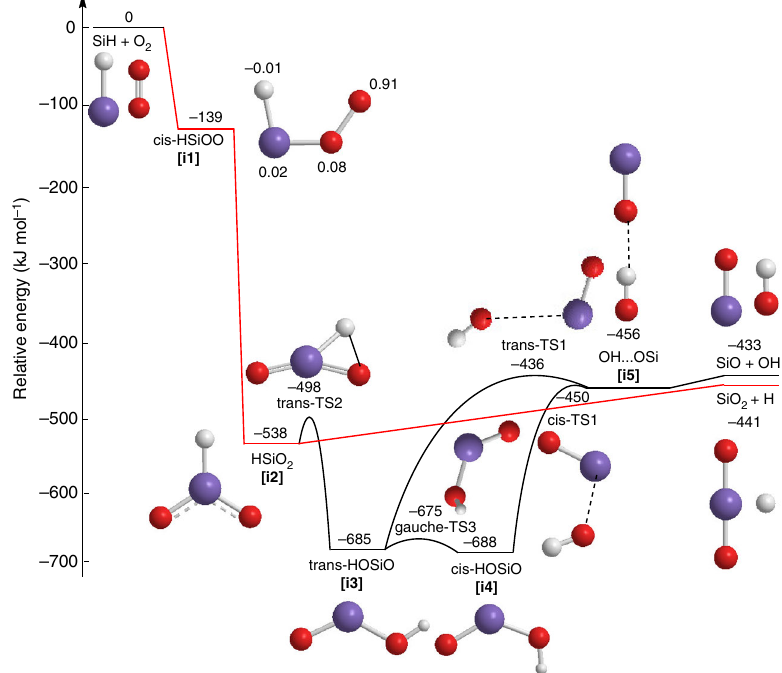
Fig. 3 Potential energy surface. The potential energy surface for the reaction of the silylidyne radical with molecular oxygen including reaction pathways energetically accessible in the crossed molecular beam experiments. The route in red highlights the reaction pathway leading to the formation of silicon dioxide plus atomic hydrogen. Relative energies are given in units of kJ mol − 1 . Note that the relative energy of silicon dioxide plus atomic deuterium is 3 kJ mol − 1 higher as compared to non-deuterated reactants, whereas for the intermediates and transition states in the SiD-O 2 and SiH-O 2 systems, relative energies are within 1 to 2 kJ mol − 1 . For [i1] , the spin density distribution is also shown. Colors of the atoms: silicon (purple), oxygen (red), and hydrogen (light